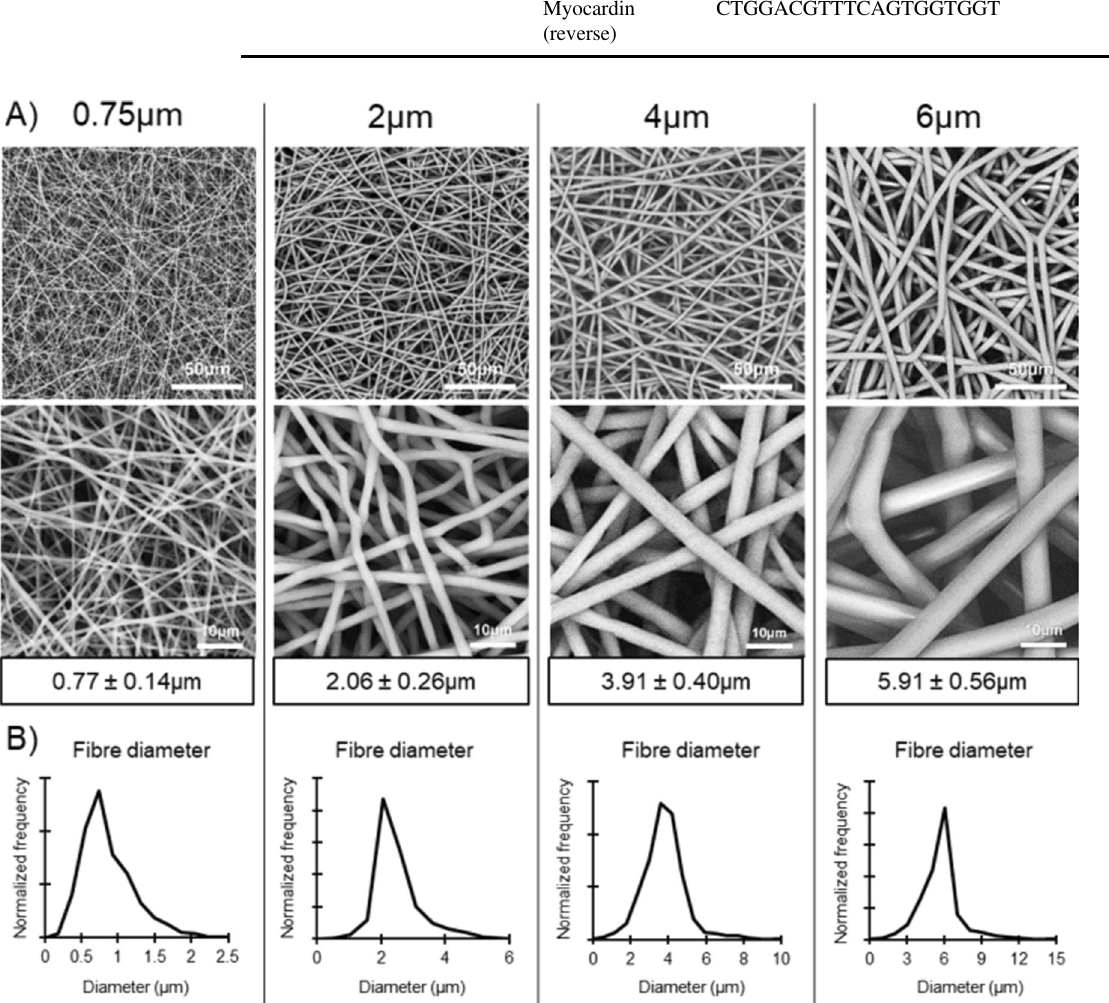
Fig. 1 A SEM images of the four electrospun scaffolds with increasing fi bre diameters. B Normalized frequency of fi bre diameters found in each